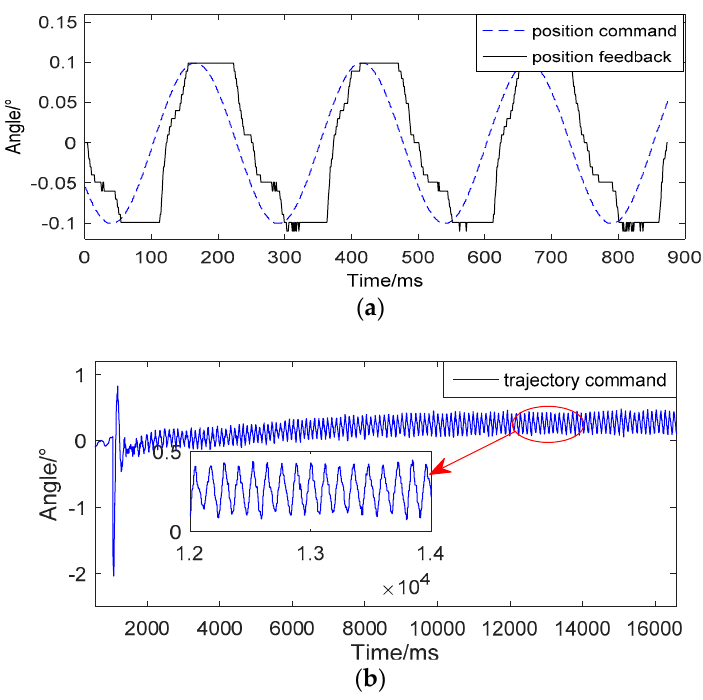
Figure 2. ( a ) The phenomena of flat top. ( b ) The phenomena of limit cycle oscillation.